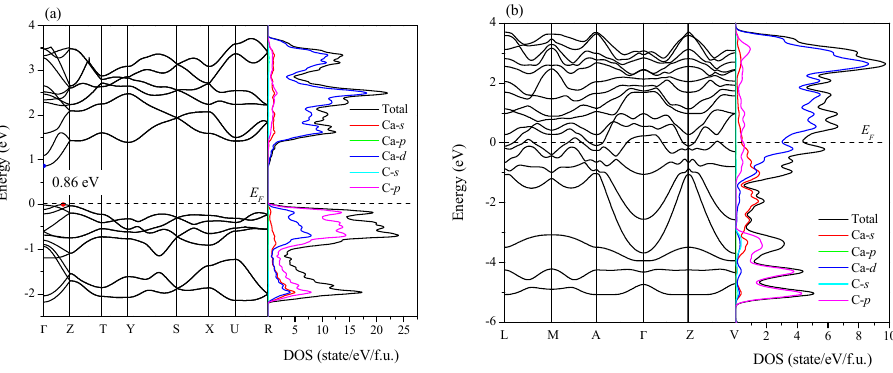
Figure 10. Electronic band structure and density of state of Pnma -Ca 2 C ( a ) and C 2/ m -Ca 2 C ( b ) at 0